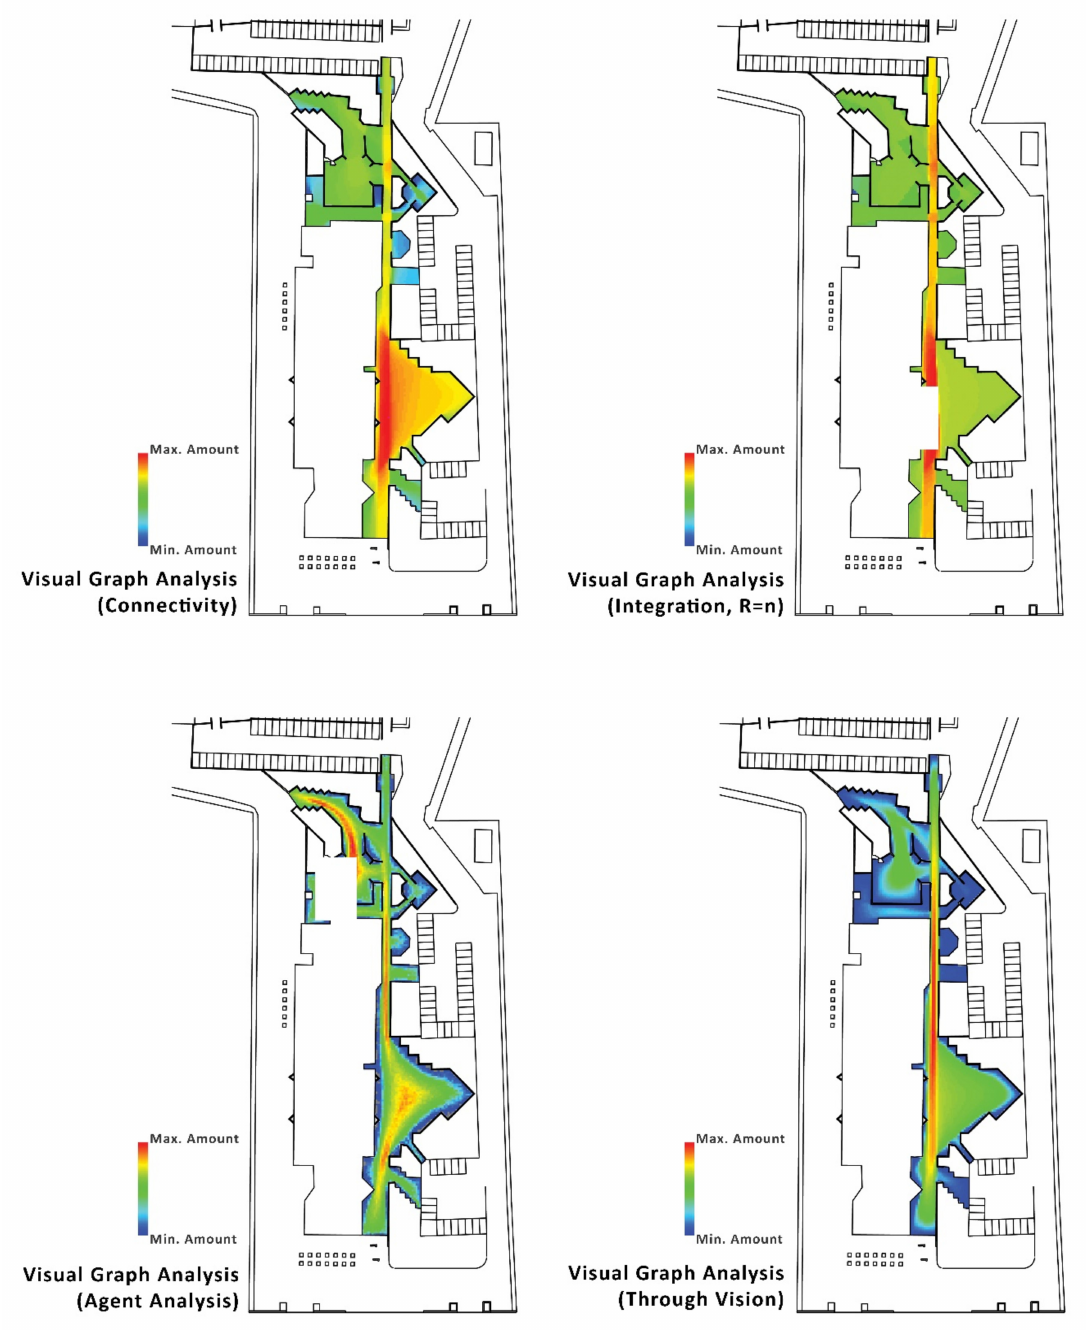
Figure 6. Visibility graph analysis (VGA) for open space